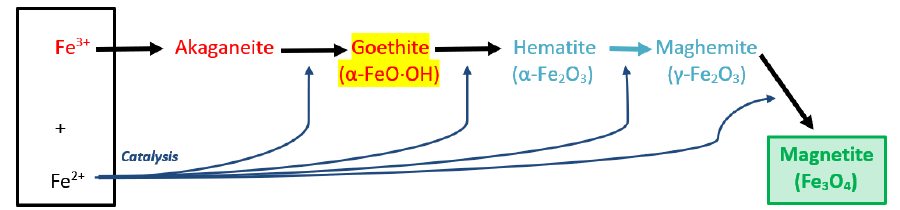
Figure 6. Formation root of MNPs via co-precipitation approach.